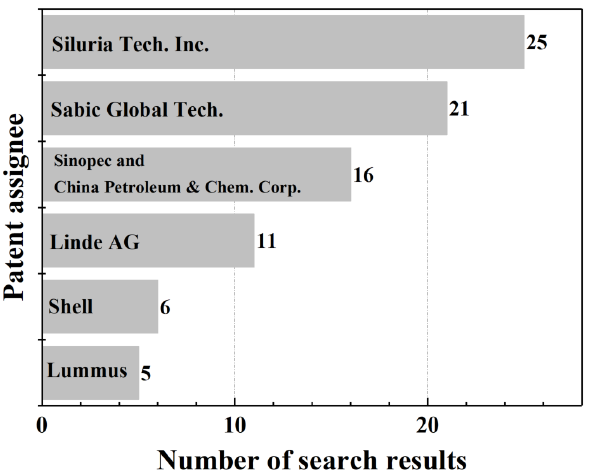
Figure 5. Filed patent distribution per assignee between 2010 and 2020, from the search using the ‘ Derwent Innovations Index ’ database from the “ Web of Science ” platform and keyword set (b). For clarity, assignees with fewer than 5 filed patents were omitted. Numbers represent 69% of the total number of searched patents.